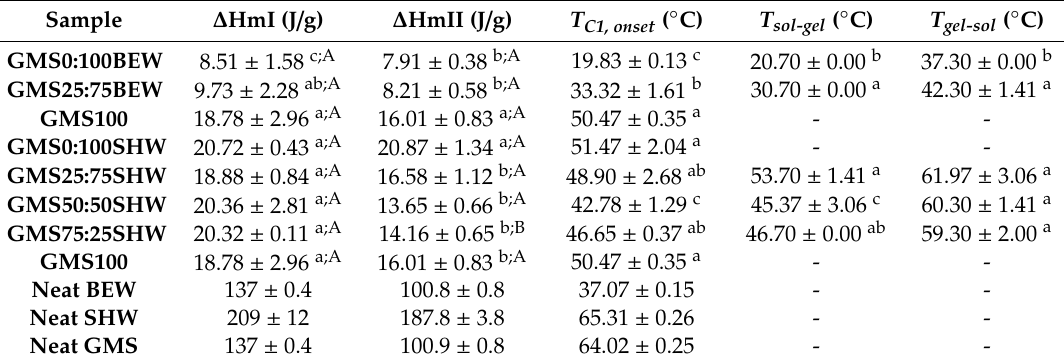
Table 2. Crystallization temperature, melting enthalpy from DSC measurements, and temperatures associated to sol-gel and gel-sol transitions from non-isothermal rheological measurements. Sample ∆ HmI (J /